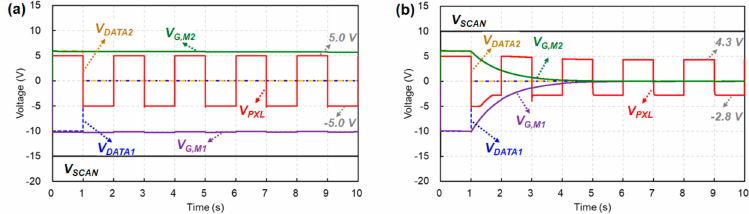
Figure 5. Simulated results to verify the long-term operation. The programming transistors were ( a ) n-type oxide and ( b ) p-type LTPS